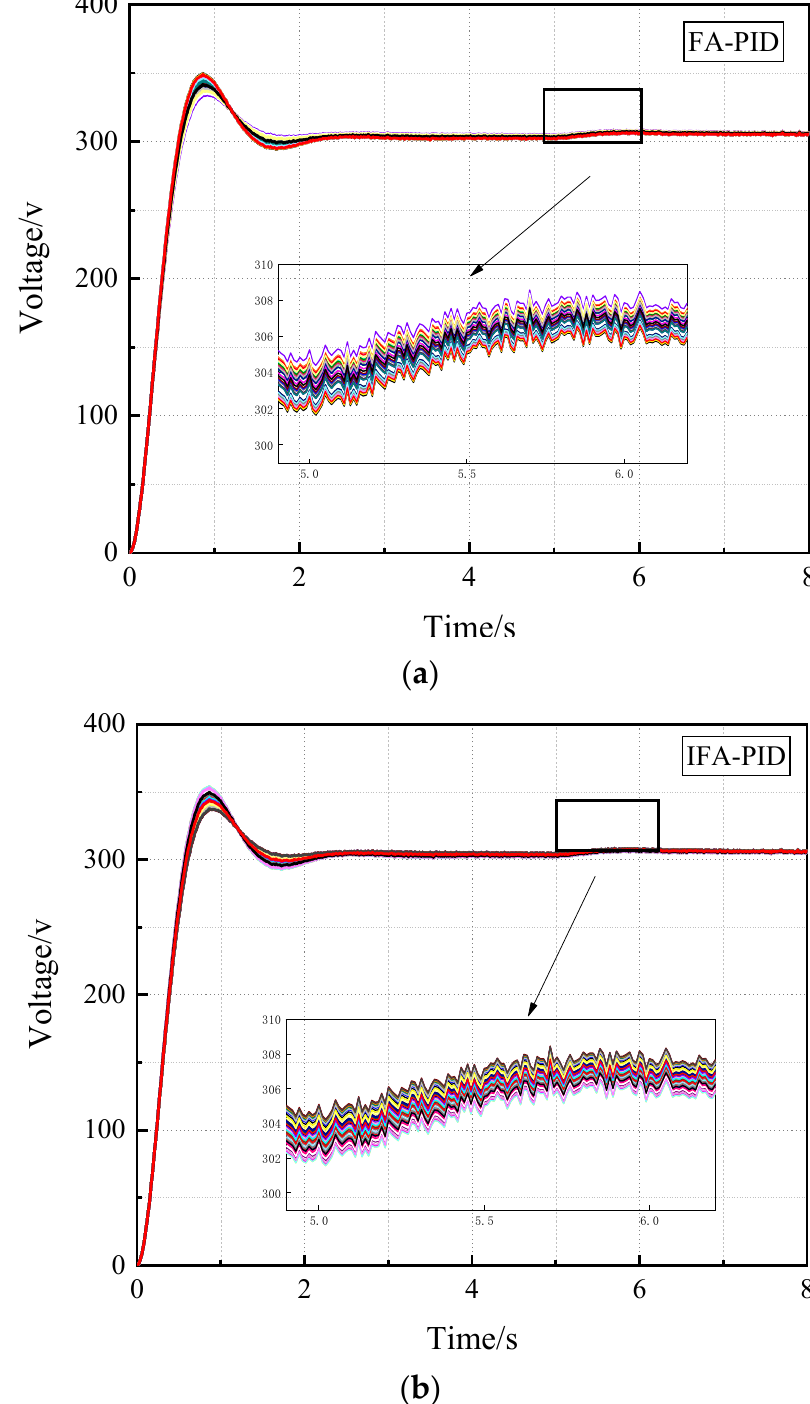
Figure 12. Monte Carlo experiment of ( a ) FA-PID and ( b ) IFA-PID control methods, wherein the lines in different colors denote system voltage outputs after the addition of a random disturbance within [20%, − 20%].